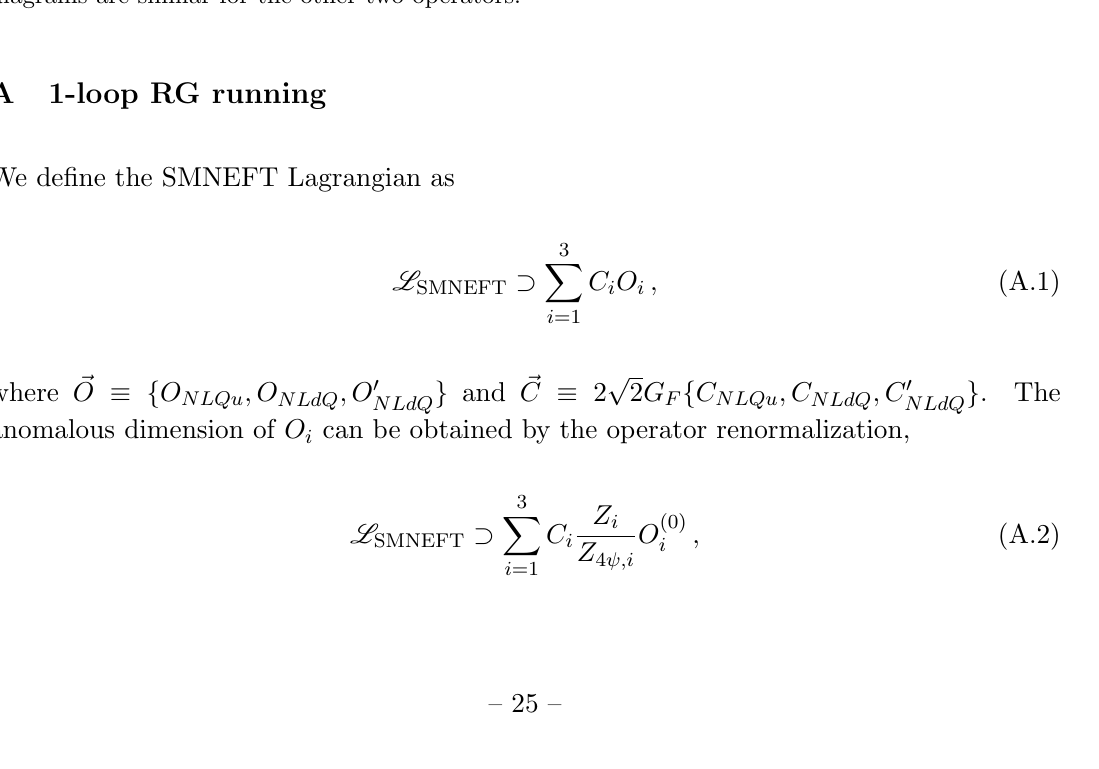
Figure 6. One-loop vertex corrections and counterterm for O NLQu above the weak scale. The diagrams are similar for the other two